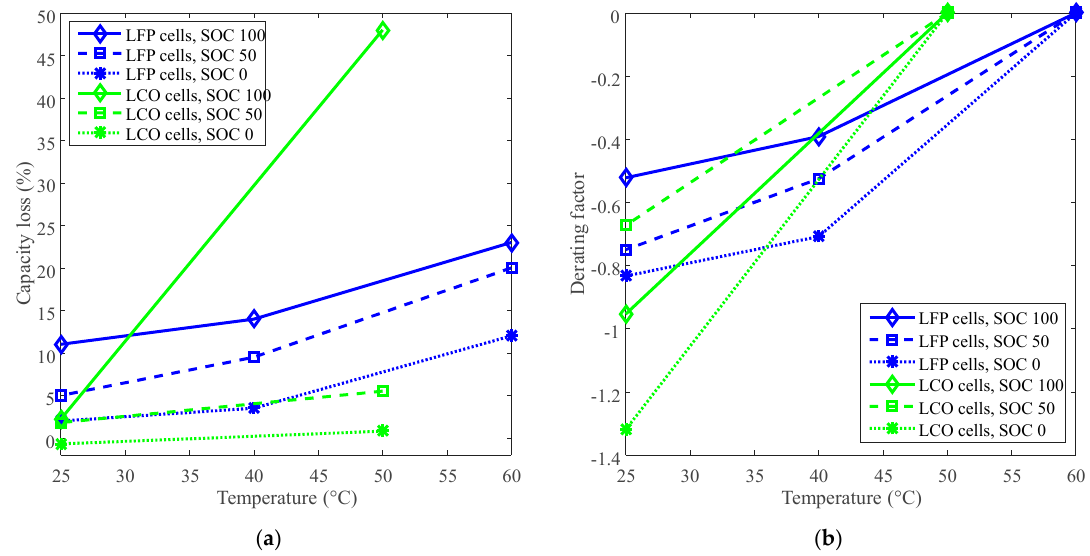
Figure 2. Derating of temperature for calendar life. ( a ) Capacity loss vs. temperature. ( b ) Derating factor vs. temperature. The derating factors were calculated according to Equation (3).